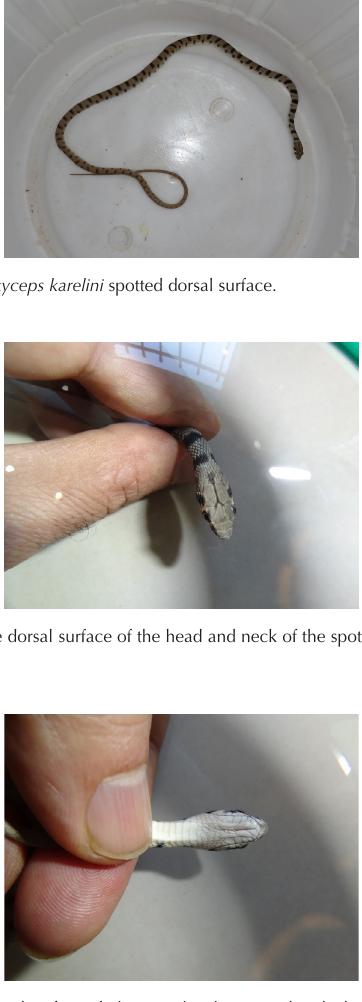
Figure 2. Kashan city, study area in Isfahan province. Figure 5. Ventral surface of Platyceps karelini spotted snake head and neck.